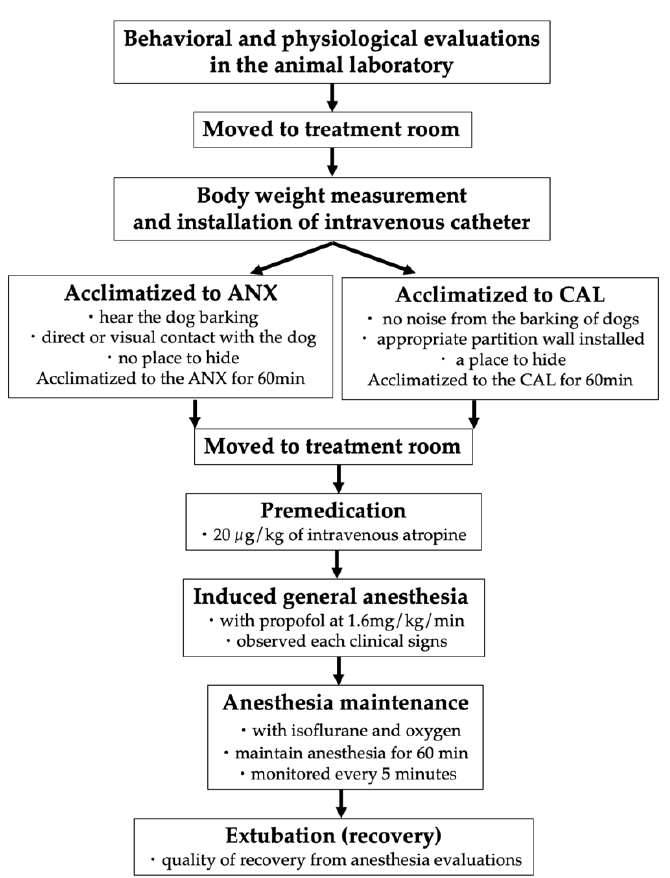
Figure 1. Experimental procedure of the study.